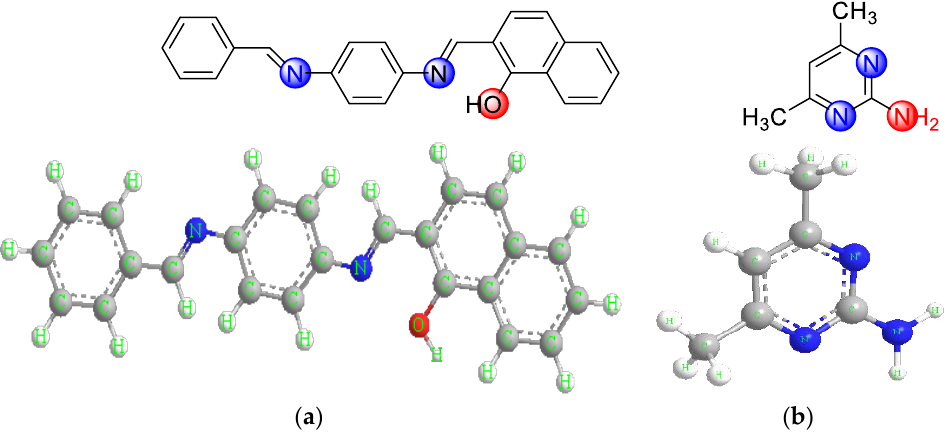
Figure 1. Structure of the ligands. ( a ) 2-((E)-((4-(((E) benzylidene)amino)phenyl) imino)methyl)- naphthalene-1-ol. ( b ) 2-amino-4,6-dimethyl pyrimidine.